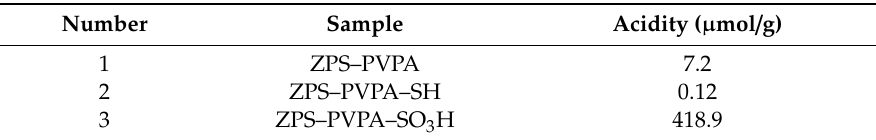
Table 1. Acidity of the samples of solid